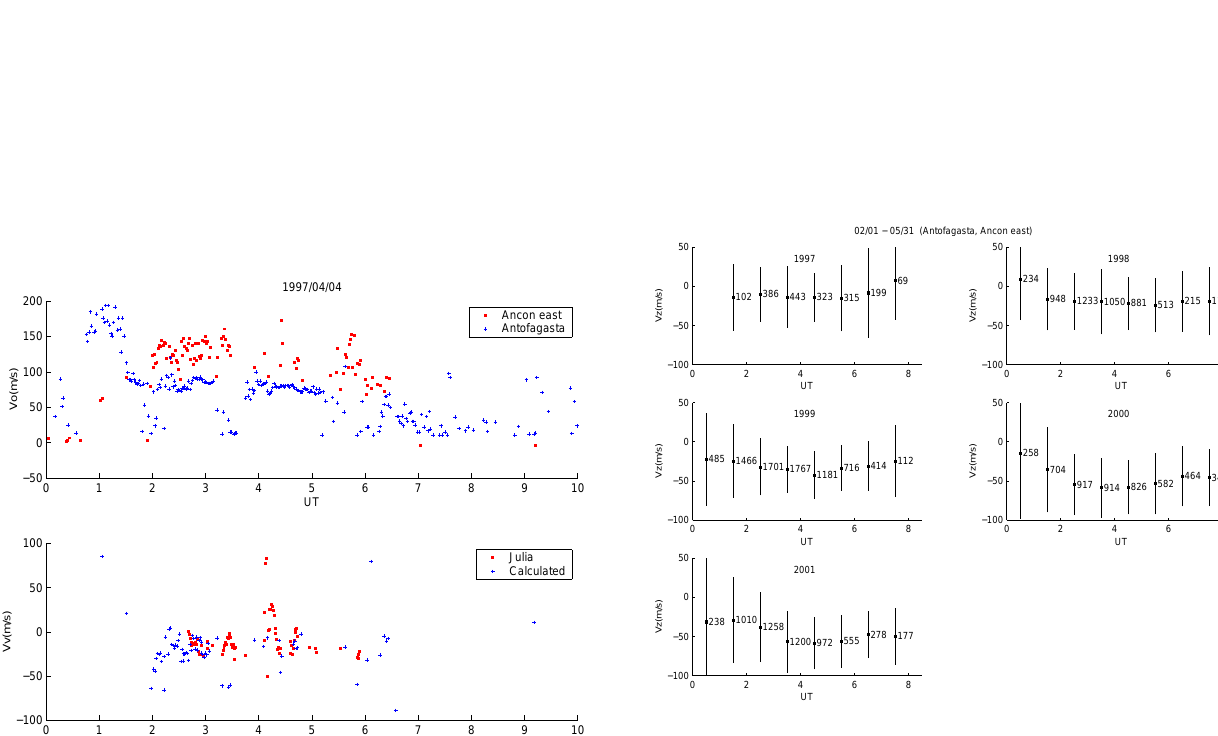
Fig. 10. (a) Average vertical drift calculated from Antofagasta and Ancon-E V 0 data vs. UT for the months February–May from 1997 to